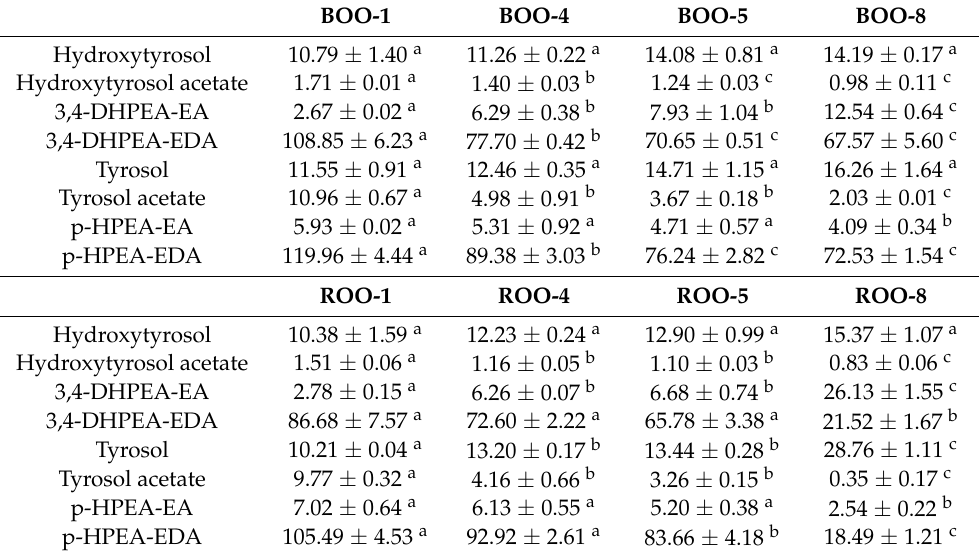
Table 4. Concentrations (mg/kg) of the oleuropein- and ligstroside-derivates (mean ± SD) of flavoured samples (BOO, ROO) in four months of the storage